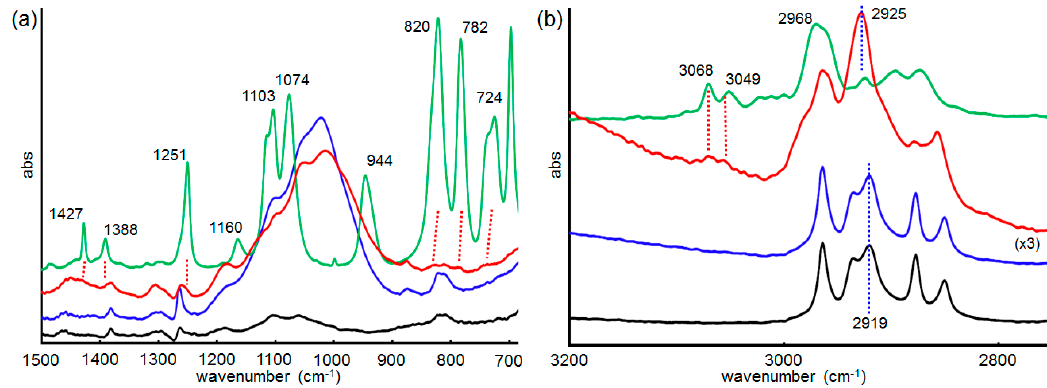
Figure 9. Infrared (IR) reflection–absorption (RA) spectra of Dod-Au (black line), Dod-Au after immersion in EtOH for 24 h (blue line), Dod-Au after immersion in EtOH with DMPS (red line), and the attenuated total reflection (ATR) spectrum of DMPS–OEt (green line) in the ( a ) 700–1500 cm − 1 and ( b ) 2800–3100 cm − 1 regions.